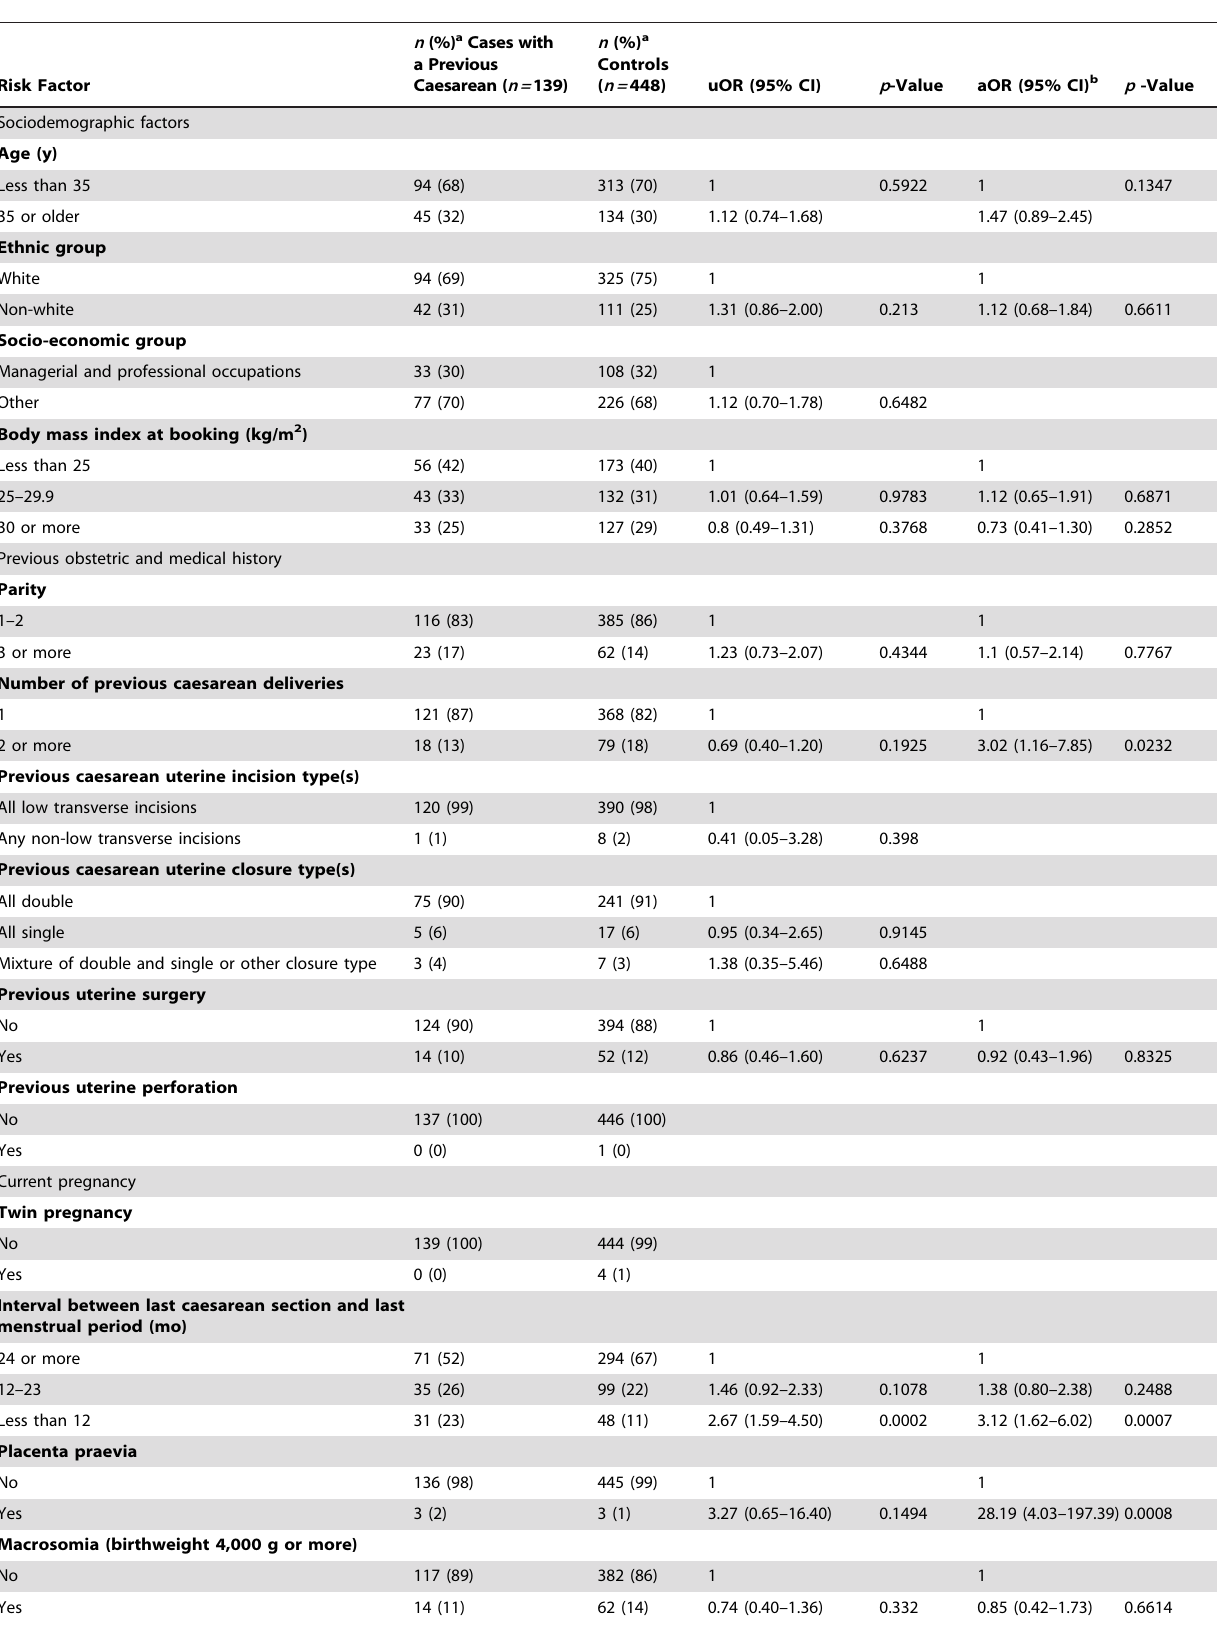
Table 3. Risk factors for uterine rupture in women with prior delivery by caesarean